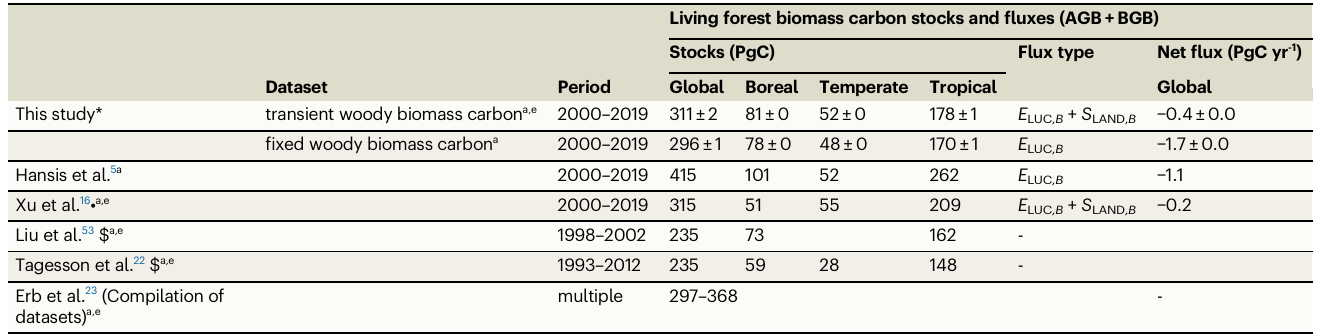
Table 3 | Comparison of forest living biomass carbon stocks (above- plus belowground) and associated fl uxes (positive for uptake and negative for release) from this study compared to a range of other recent